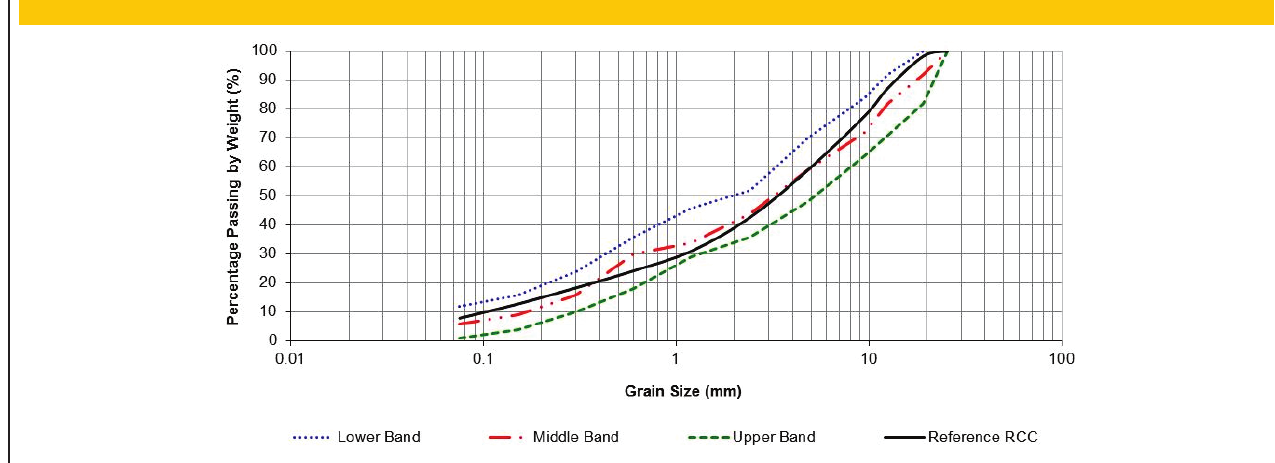
Figure 1 – Grading curves of Pittman & Ragan (1998) and reference RCC